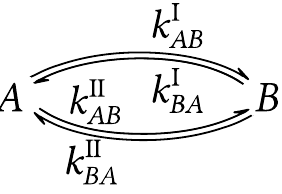
Figure 2. Spin kinetics of two-state exchange where two independent processes are